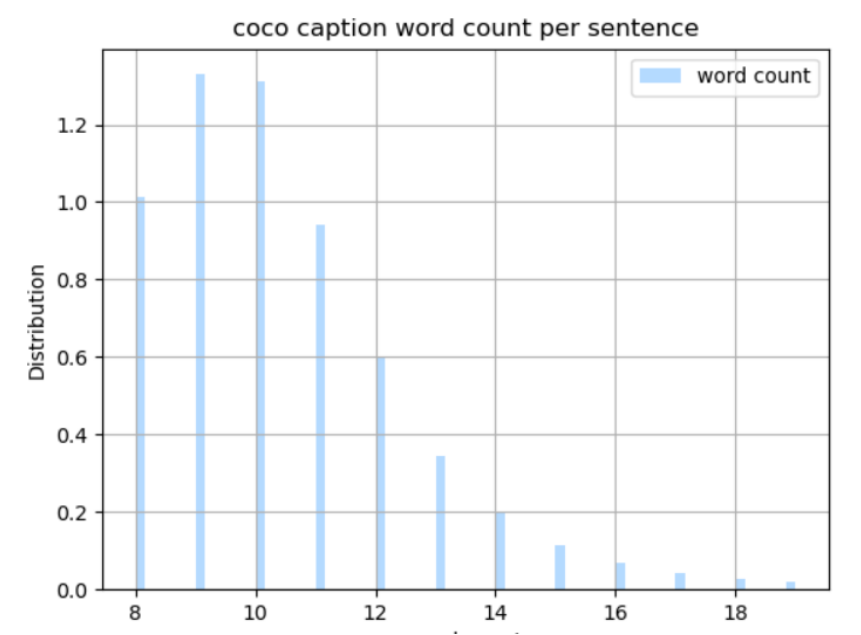
Figure 3. Chart of the number of words per sentence for the training data of the COCO captioning